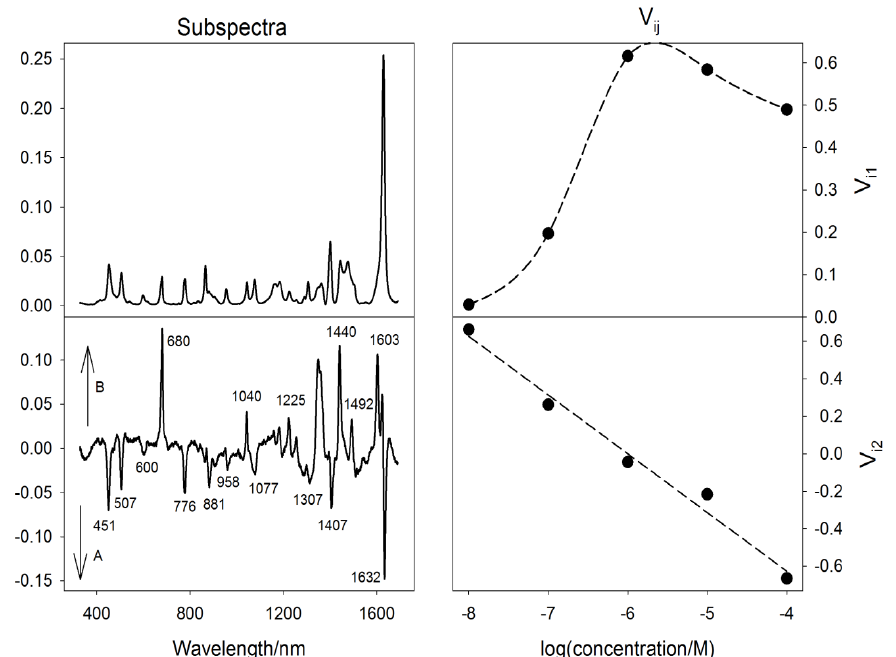
Figure 11. Results of factor analysis of concentration-dependent SERS measurements of methylene blue (MB). Profile of the V i1 coefficients reflects the variation in MB SERS intensity with concentration. Profile of the V i2 coefficients and the shape of the second subspectrum reveal a systematic decrease in the ratio of EFs for B/A modes with increasing concentration (cf. Figure 10).